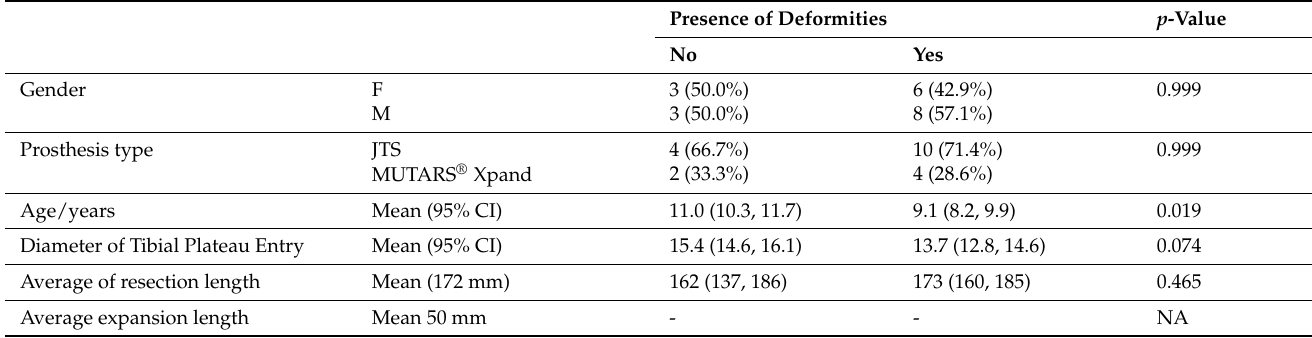
Table 2. Association between the presence of deformities and patient characteristics [15,16].